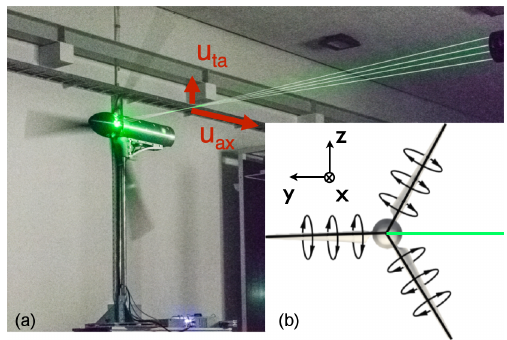
Figure 4. (a) Clockwise-rotating MoWiTO 1.8 with 2D LDA prob- ing axial u ax (along x axis) and tangential u ta (along z axis) velocity components in the bisectrix of two blades. (b) Scheme of counter- balancing bound circulation of the evenly loaded blades of front view of clockwise-rotating rotor. The LDA measurement line is in- dicated in green (adapted from Herráez et al.,